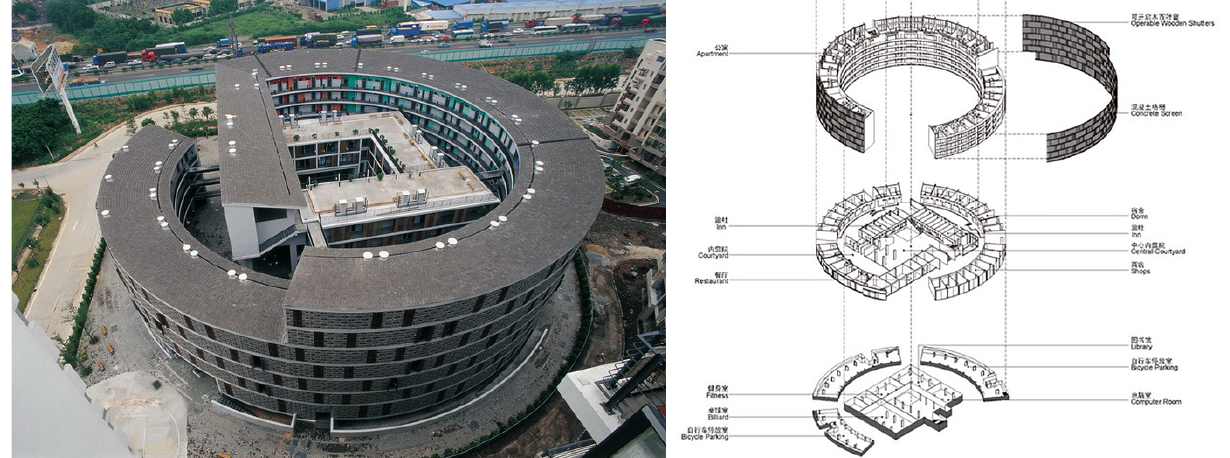
Figure 10. Tulou Collective Housing, Guangdong, 2008, by Urbanus. Source: Urbanus (n.d.).